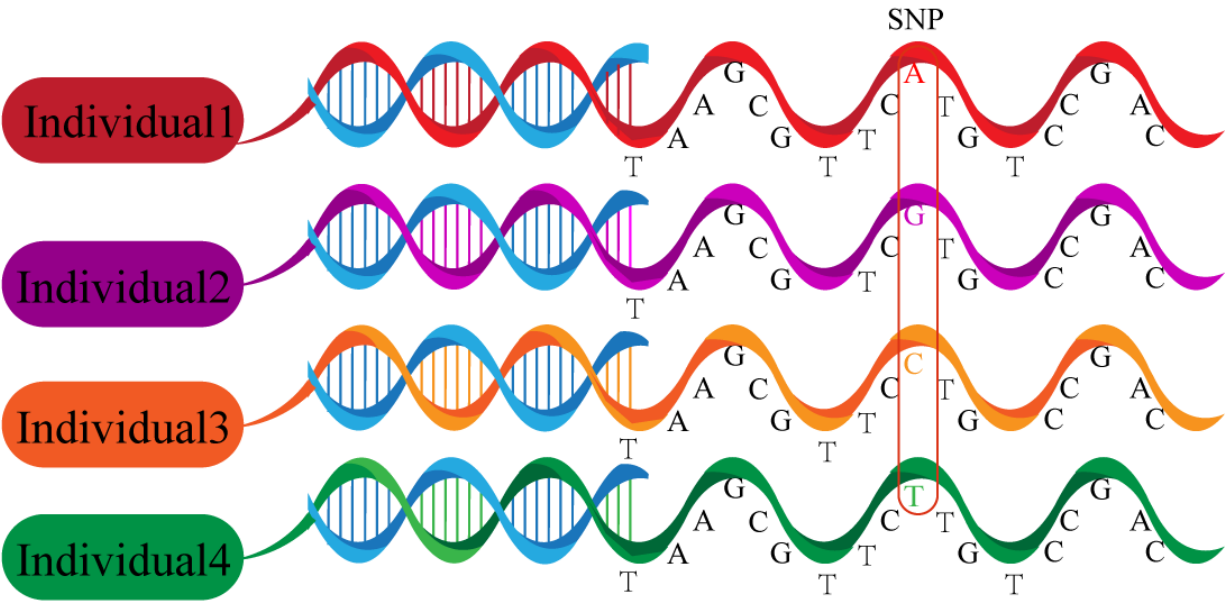
Figure 2. Single-nucleotide polymorphisms. Polymorphisms of a DNA sequence caused by a single nucleotide variation at the genomic level between individuals .